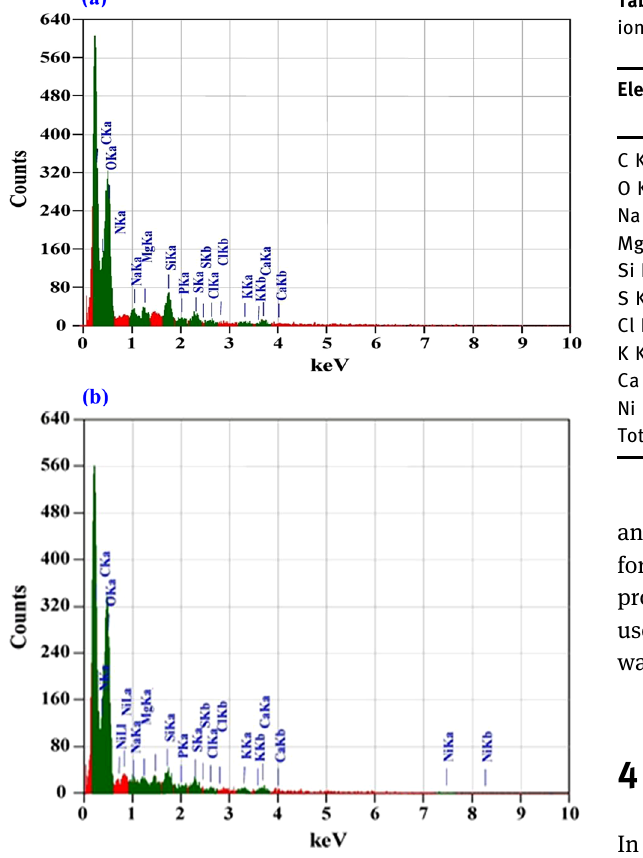
Table 9: EDS analysis of G. amansii biomass after adsorption of Ni 2